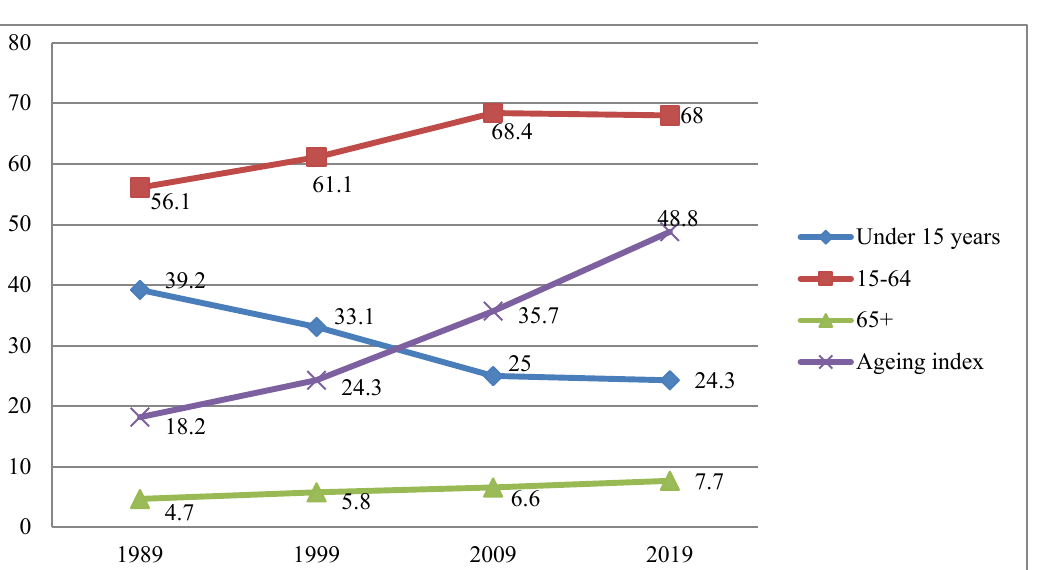
Figure 2. The proportion of the population by age group, aging index, and dependency ratio for 1989–2019.Source: Population and Housing Censuses (Central Census Steering Committee 2010, p.